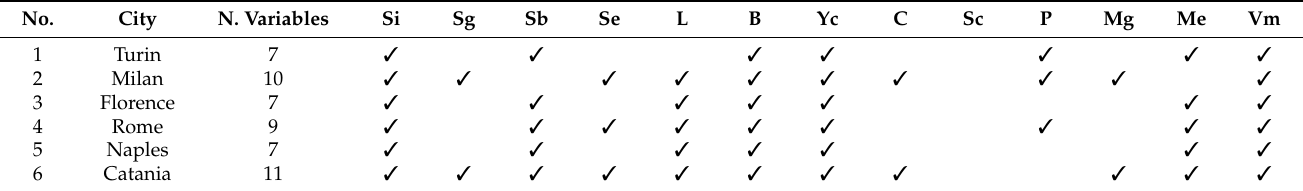
Table 8. Variables selected by the models generated by EPR-MOGA for each study sample for Phase II.